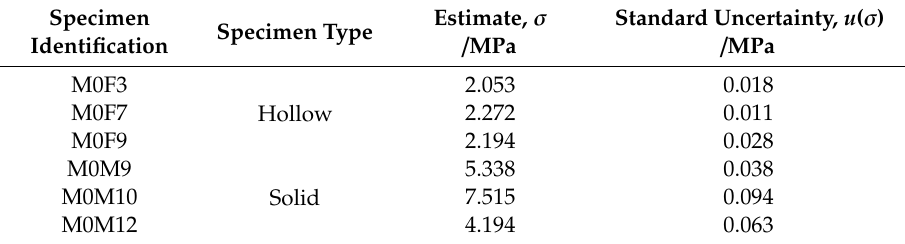
Table A5. Compressive strength measurements in the tested masonry